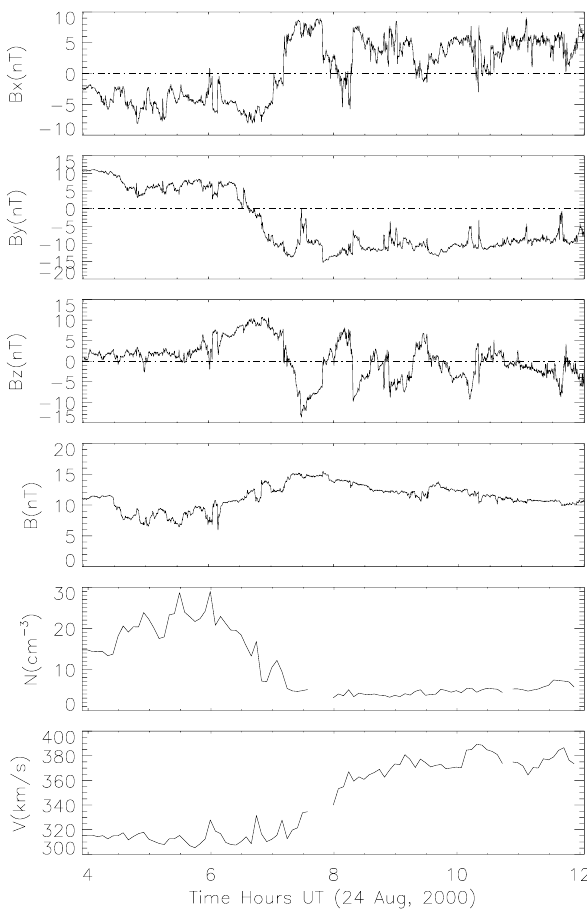
Fig. 3. The solar wind conditions measured by the ACE spacecraft between 04:00 and 12:00UT on 24 August 2000. The six panels show B X , B Y , B Z , B , N and V ,